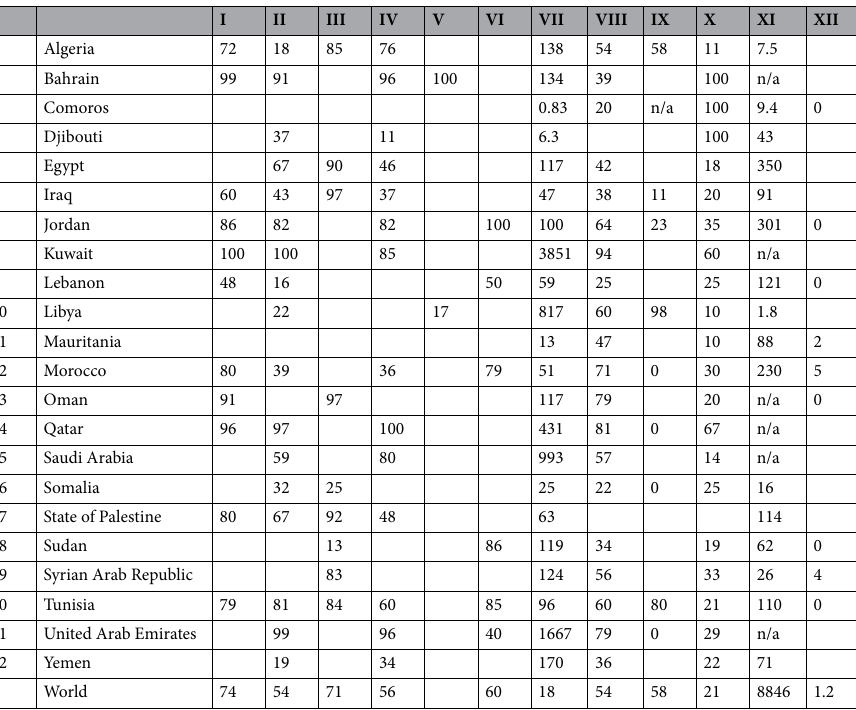
Table 8. Current SDG 6 status in Arabsphere. An empty cell, there is no reported data; n/a, not